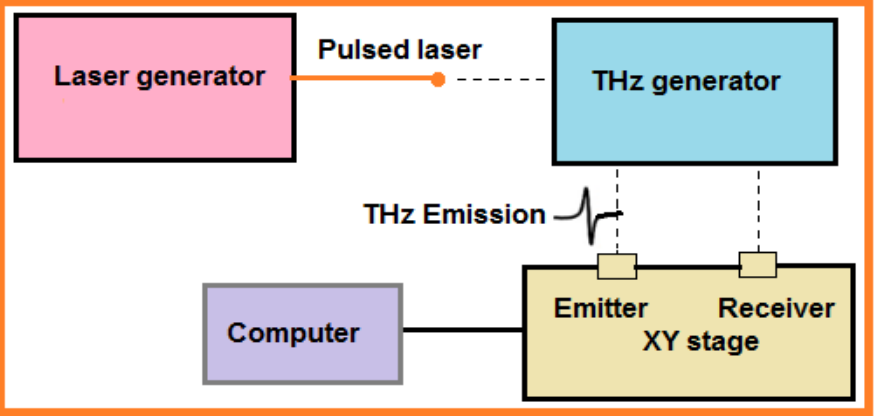
Figure 13. Schematic diagram of a THz generator and imaging system.